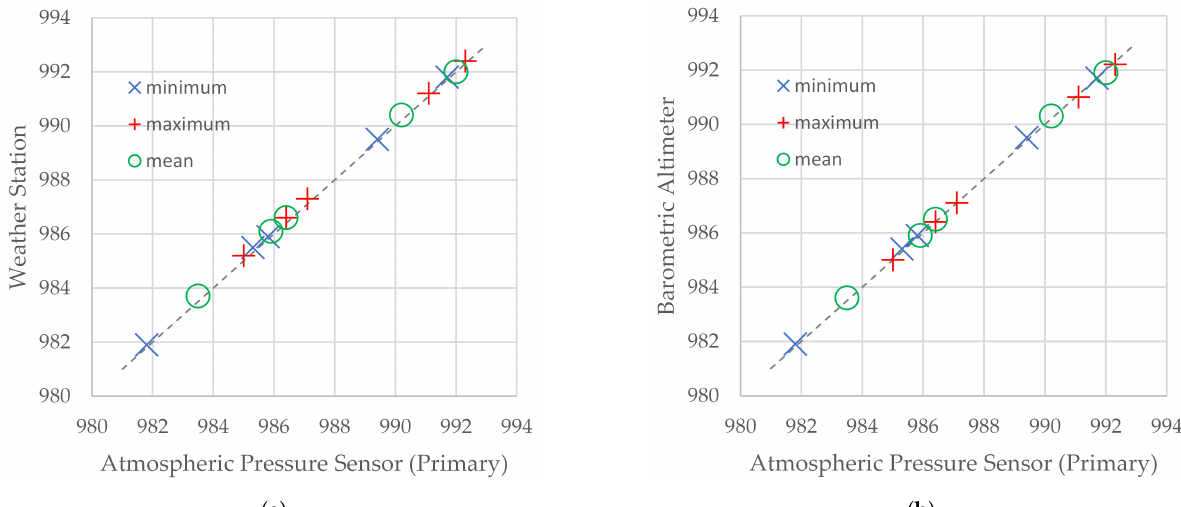
Figure 3. Scatter plots for statistics of atmospheric pressure measured by a reference device and the primary atmospheric pressure flying weather station. Reference device: ( a ) the SBS-WS-400 weather station; ( b ) barometric altimeter.